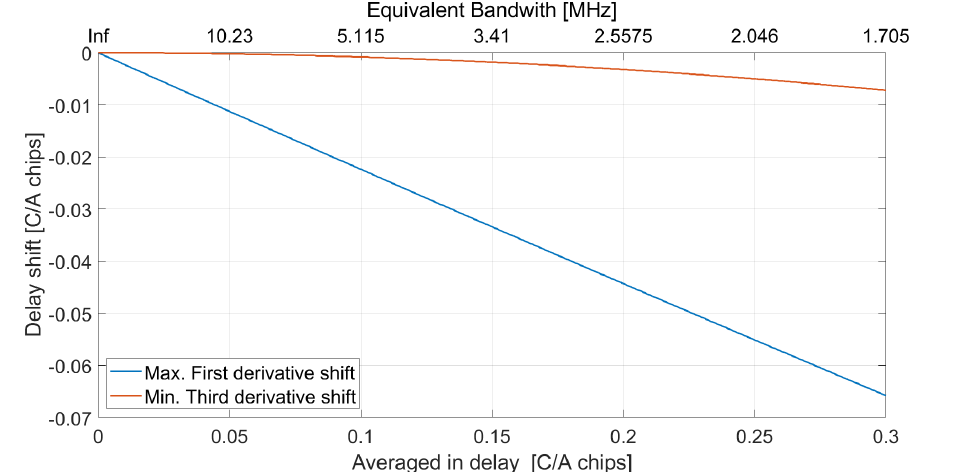
Figure 8. Delay position tracking of the maximum of the first derivative and minimum of the third derivative as a function of the bandwidth. The first derivative maximum shifts towards negative delays for finite bandwidths, while the third derivative minimum remains closer to the zero delay for a wider range of bandwidths (larger than ∼ 5